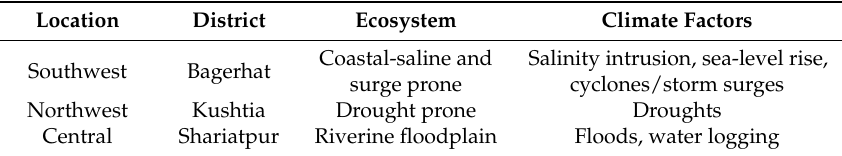
Table 1. Study areas and their ecosystem and climatic factors. Location District Ecosystem Climate Factors